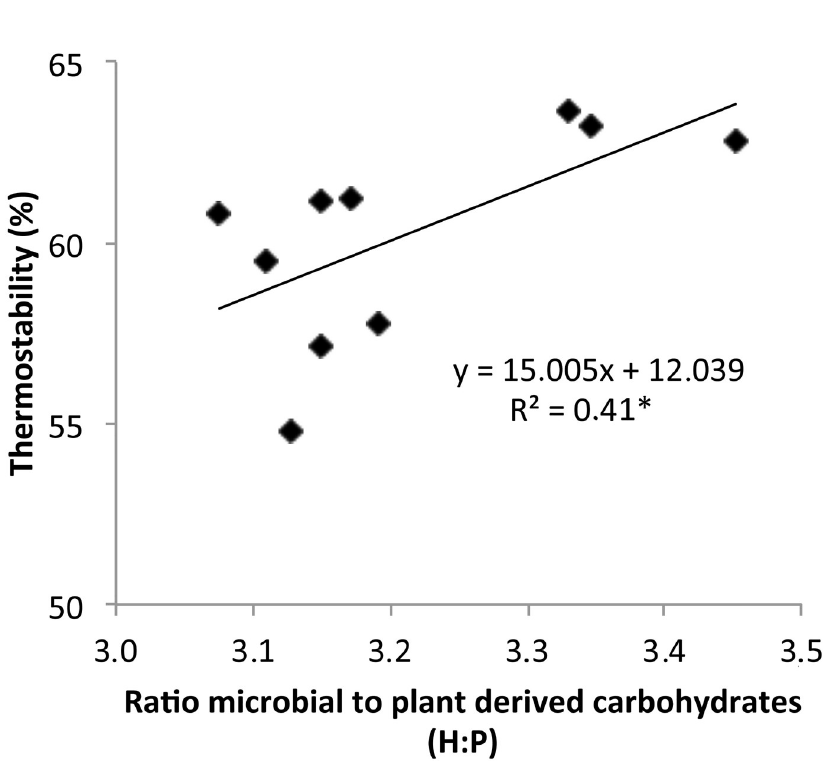
Fig 3. The correlation of thermal stability (calculated as ratio of the measured ion intensities � 410˚C proportional to the total ion intensity (in 10 6 counts mg -1 ) of the sample and expressed as percentage (%)) with the ratio of microbial versus plant-derived carbohydrates (H:P, hexose:pentose ratio) of microaggregate size fraction of the topsoil samples. The level of significance is given by superscript asterisks: � P < 0.05.